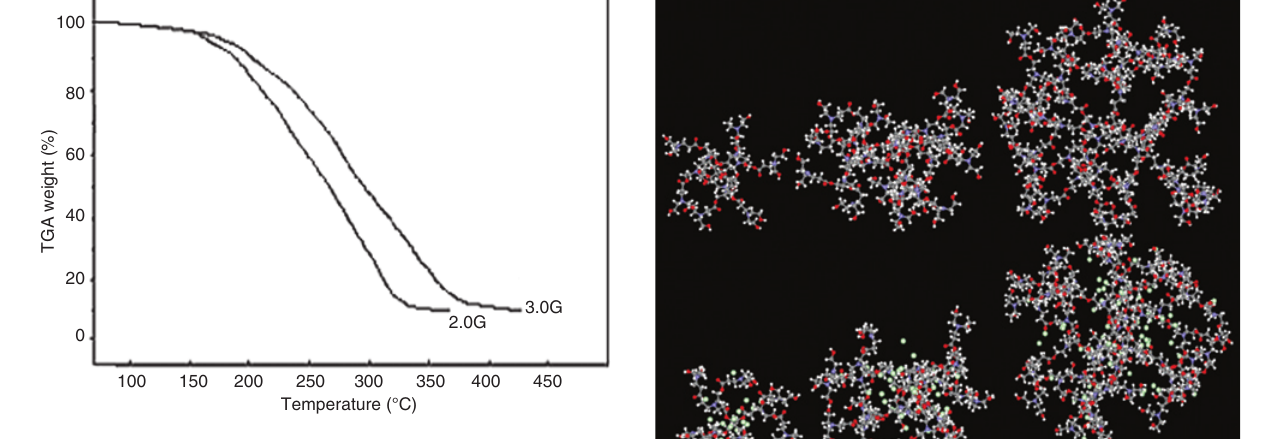
Figure 3 Thermogravimetric analysis HPAE.